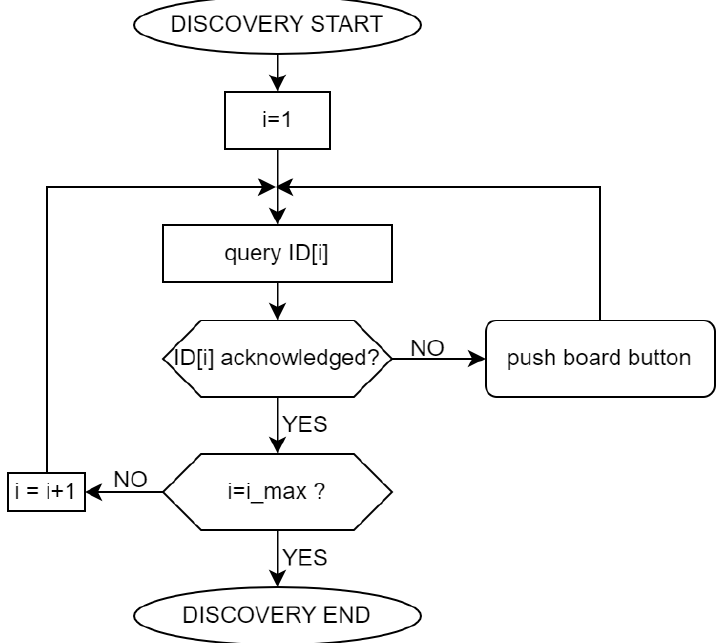
Figure 6. Flowchart diagram illustrating the discovery procedure that maps tiles (1 to i max ) as required by the game